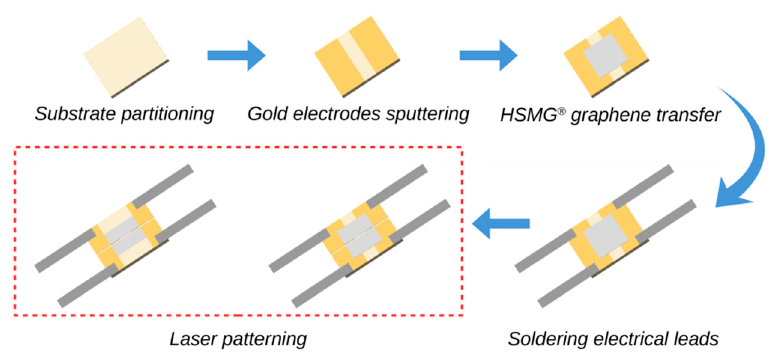
Figure 3. Method of sample preparation. HSMG ® : High-strength metallurgical graphene.